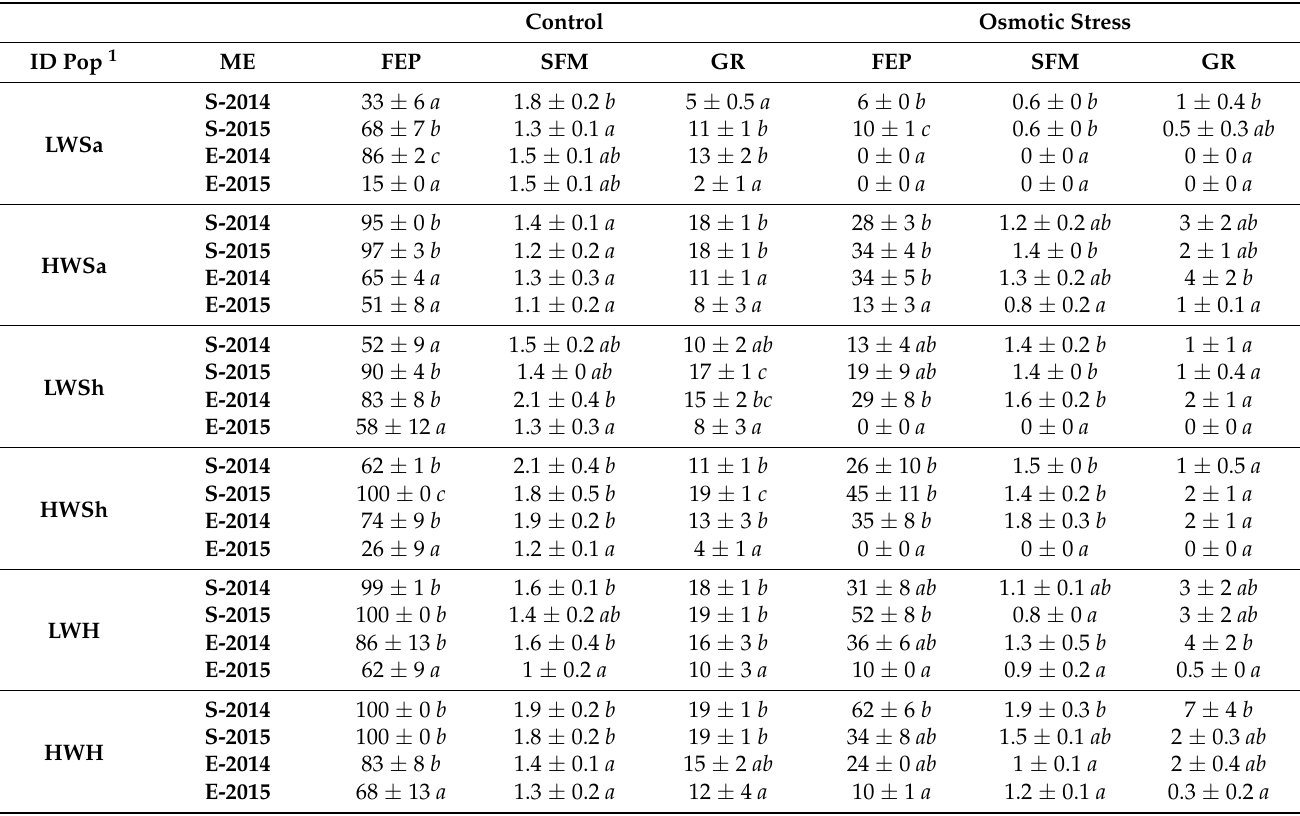
weight-humid origin. LWS: low weight-saline origin. Different letters indicate statistically significant differences in seed weight between populations within each origin (LSD Fisher, p < 0.05). Table 3. Mean values ( ± standard error) of final emergence percentage (FEP), seedling fresh mass (SFM) and Maguire’ germination rate (GR) for Leptochloa pluriflora populations and maternal environ- ment (ME) of seeds evaluated under osmotic and non-osmotic stress. Control Osmotic